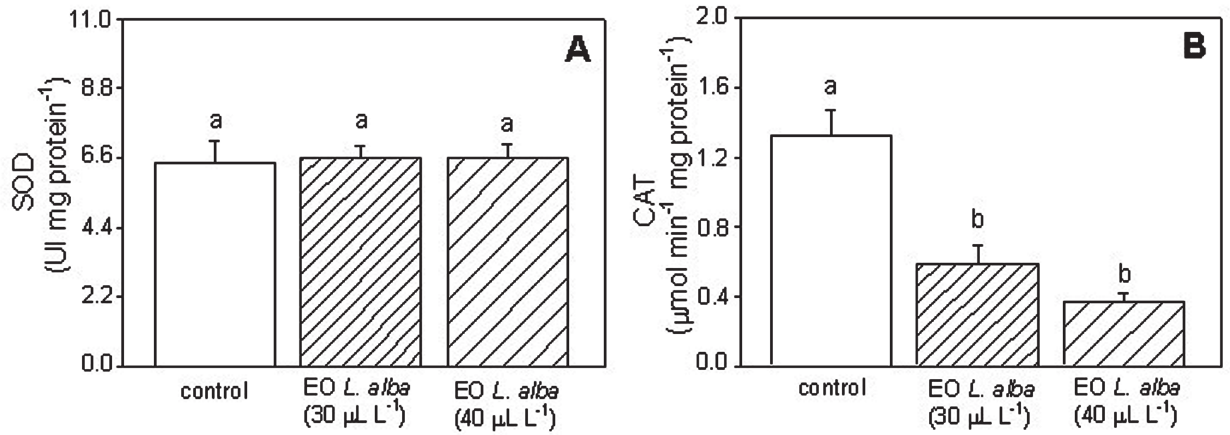
Fig. 1. Superoxide dismutase (SOD) and catalase (CAT) activities (A and B, respectively) in the liver of silver catfish ( Rhamdia quelen ) transported in plastic bags containing water treated with the essential oil from Lippia alba . The values are expressed as the means ± SEM. Different letters indicate levels of significance between the treatments